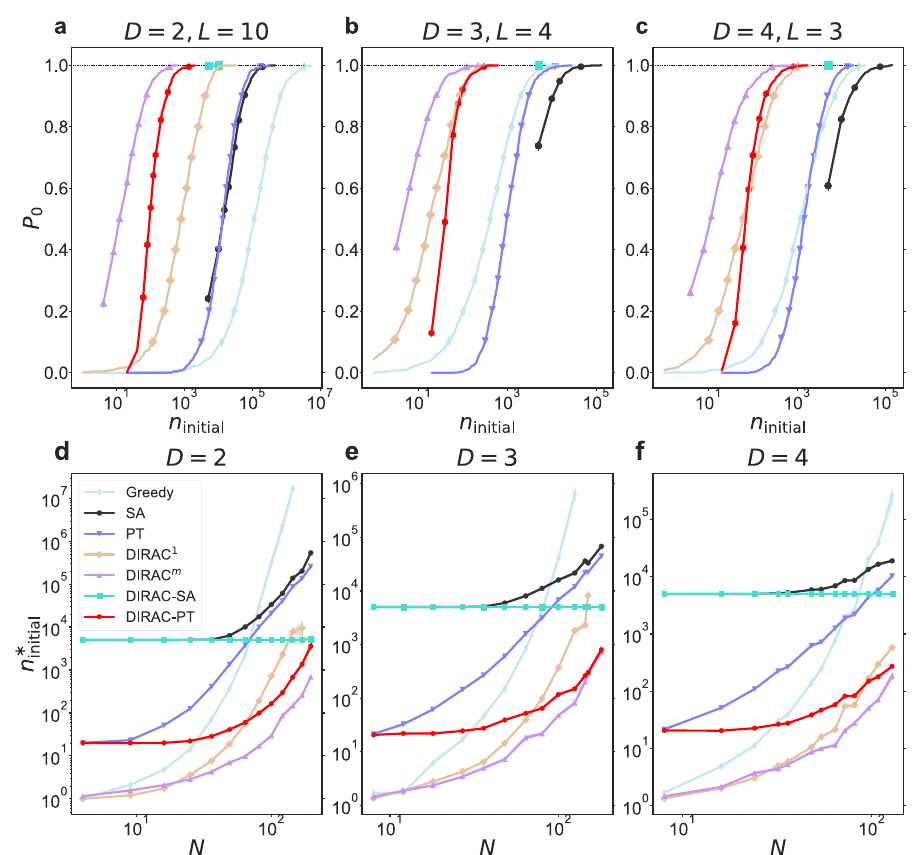
Fig. 4 | Performance of different methods in fi nding the ground state. To runs, and showed the results of mean and standard error of the mean (SEM) (shaded area, comparable with the line width or data point symbol size in most compare the ability of fi nding the exact ground states, we evaluated different cases) of different methods on different sizes. Log scale was used for visualization methods on small spin glass systems for which the true ground state can be purpose.Notethattohaveavarietyofsystemsizes,insteadofusingthesameside L computed by the branch-and-bound-based solver Gurobi 49 . In ( a – c ), the quantity we chose to compare is the probability of fi nding the ground state, denoted as P 0 , for each dimension, we considered different sides for different dimensions. By which isempirically calculated as the fraction of 1000 random instances for which tuning the sides ( L 1 , ⋯ , L D ),we generateda variety ofsystemsize N = L 1 × ⋯ × L D . In our implementations, one run of SA and DIRAC-SA needs 5000 initial con fi gura- thegroundstateisfound(andcon fi rmedbyGurobi).Wecomputed P 0 asafunction ofthenumberofdifferentinitialcon fi gurations,denotedas n initial .In( d – f ),weplot tions, and for some of these small systems, one run of DIRAC-SA is able to reach , i.e., the minimum value of n initial where P 0 reaches 1, as a function of system their exact ground states. As a result, the curves of DIRAC-SA are shown to be n * initial , we generated 100 random instances for each size, and size N . To compute n * independent of these presented sizes. Also, the data points for larger N fl uctuate initial performed 10 independent runs for each instance. The minimum number of initial more because we calculated fewer samples due to the computational resource con fi gurationsthatisrequiredbyeachmethodtoobtainthetruegroundstatewas returnedasthe resultof one run. We averaged n * over these 1000independent initial